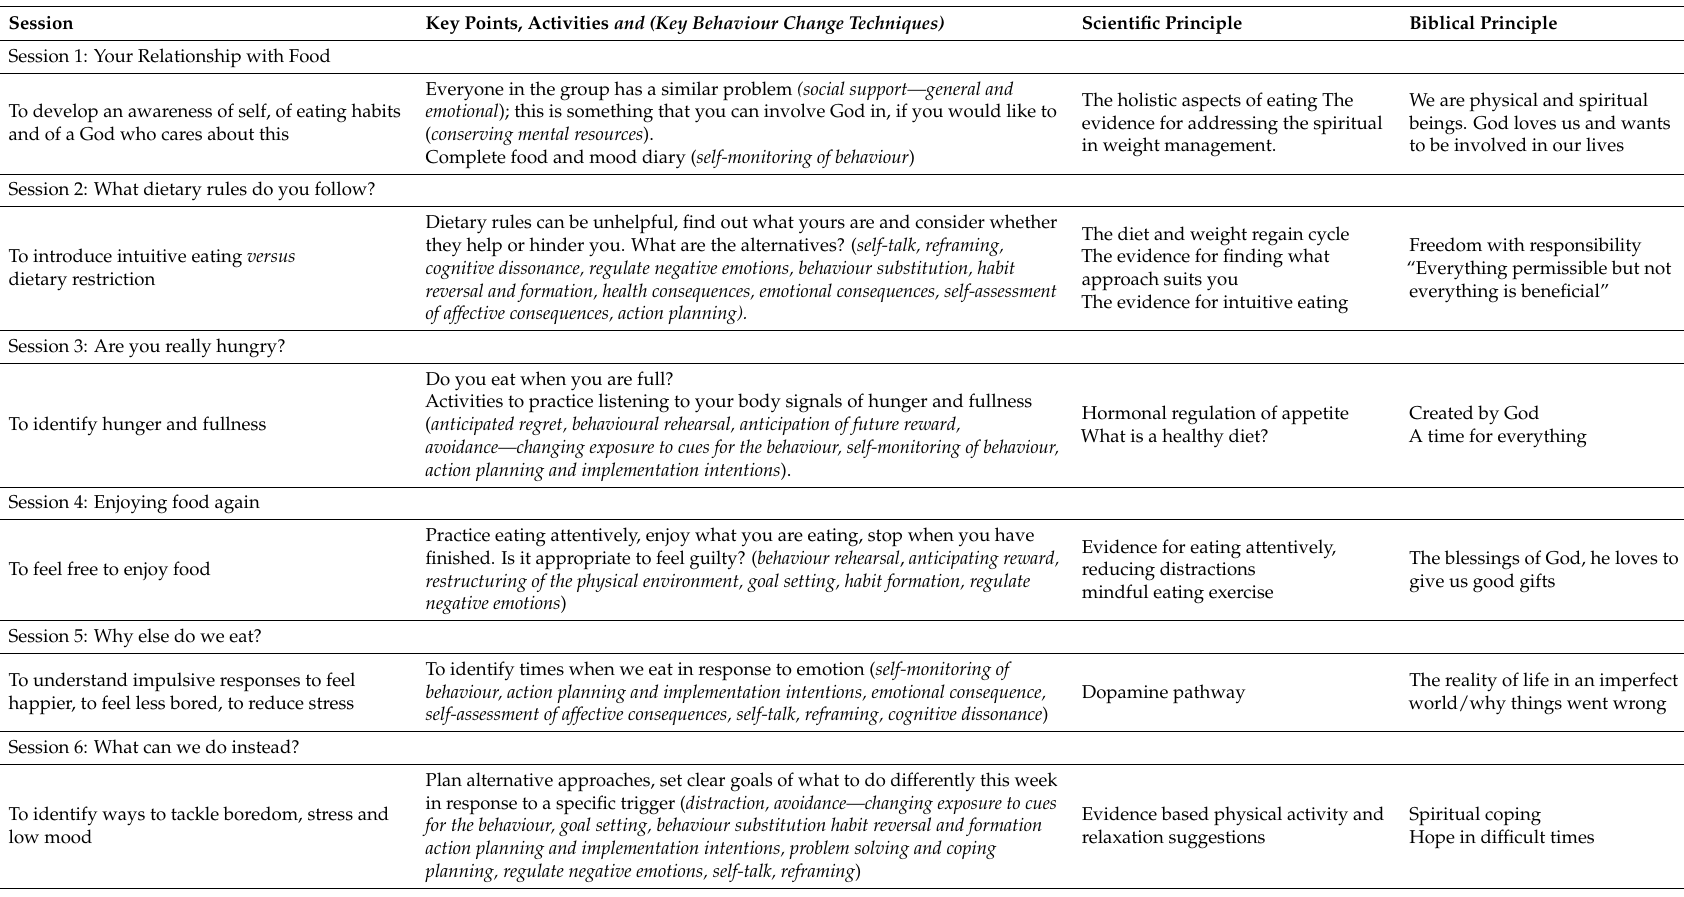
Table 1. Content and behavior change techniques of Taste and See. Key Points, Activities and (Key Behaviour Change